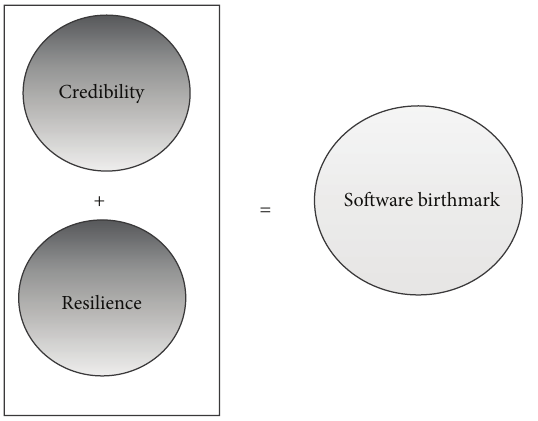
Figure 2: Properties based software birthmarks.